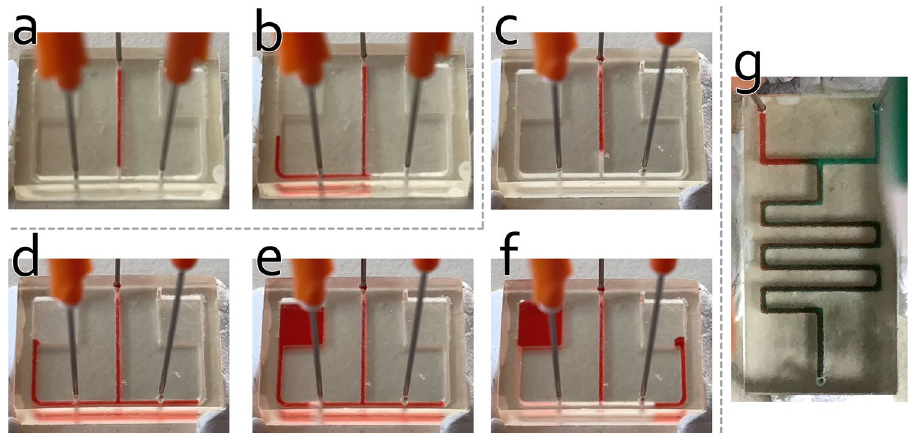
Figure 5. Pictures of the experiments. ( a , b ) Experiment #1 at different points in time: ( a ) fluid is supplying into the chip; ( b ) right pressure inlet points (pump 3) is supplied with air pressure. Hence right channel is blocked, fluid can only flow into the left channel. ( c – f ) Experiment #2 at different points in time: ( c ) fluid is supplying into the chip; ( d ) fluid flow into the left and right channel. Owing to the dimension variation of the channels, differences in hydraulic resistance happen, resulting different flow speed in left and right channels; ( e , f ) left pressure inlet points (pump 2) is supplied with air pressure. Hence fluid is split and transported to corresponding reservoir. ( g ) Picture of passive mixing (experiment #3) of two different colored samples using the system.